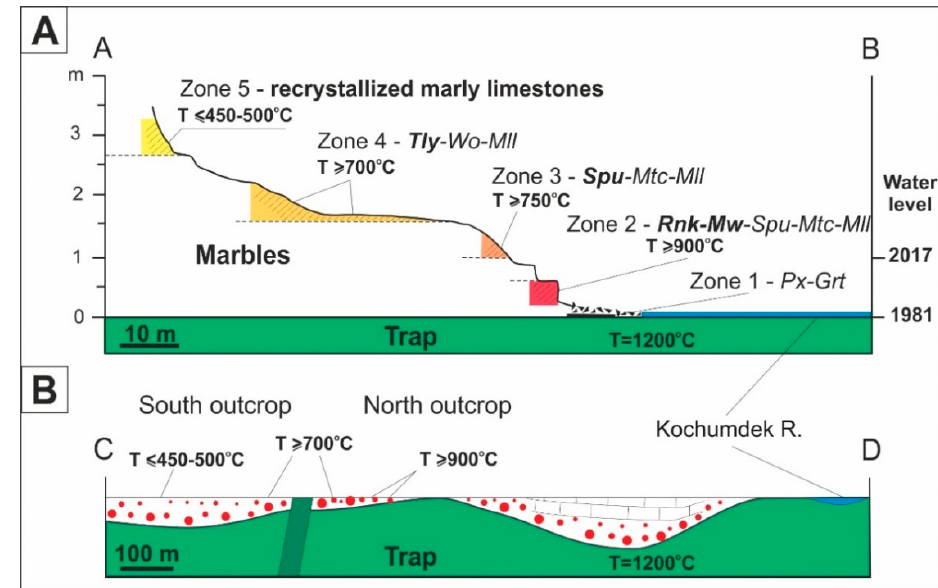
Figure 4. Schematic cross sections of sampling site along lines A-B ( A ) and C-D ( B ) (symbols are shown in Figure 2). ( A ) Temperature zoning of the Kochumdek contact aureole. Dash lines correspond to outcropping sampling sites. Left vertical axis shows thickness of metamorphic rocks (m). Zero level is at intrusion top. ( B ) Simplified profile of the Kochumdek intrusion top. Modified version after [30]. Grt = garnet, Mll = melilite, Mtc = monticellite, Mw = merwinite, Px = pyroxene, Rnk = rankinite, Spu = spurrite, Tly = tilleyite, Wo = wollastonite.